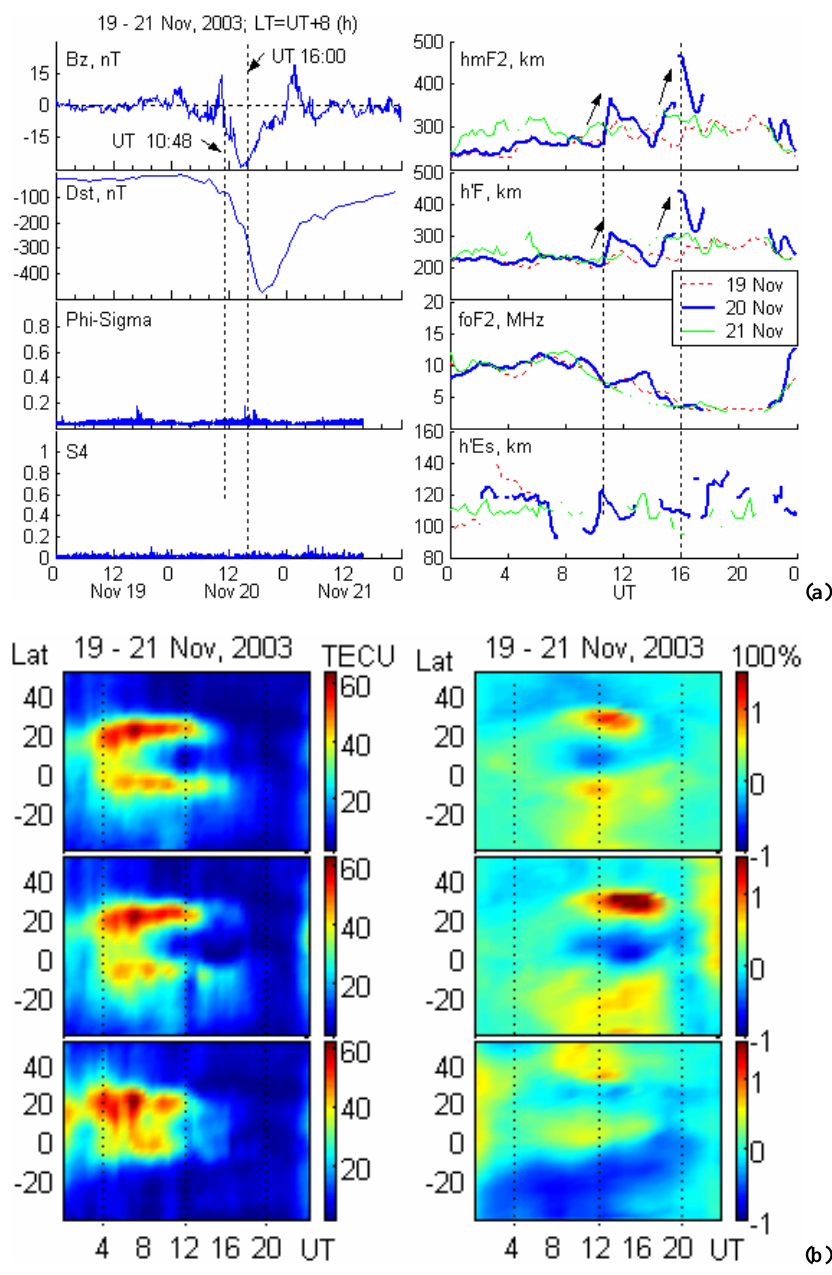
Fig. 5. (a) B z component of IMF, D st index, Phi-Sigma and S4 index; hm F2, h 0 F, fo F2 and h 0 Es for the period 19–21 November 2003. (b) Figure. 5b. Latitudinal variation of TEC (left) and RTEC (right) along geographic longitude 110 ◦ E for 19 November (top panel), 20 November (middle panel) and 21 November (bottom panel), 2003, show the EIA development.